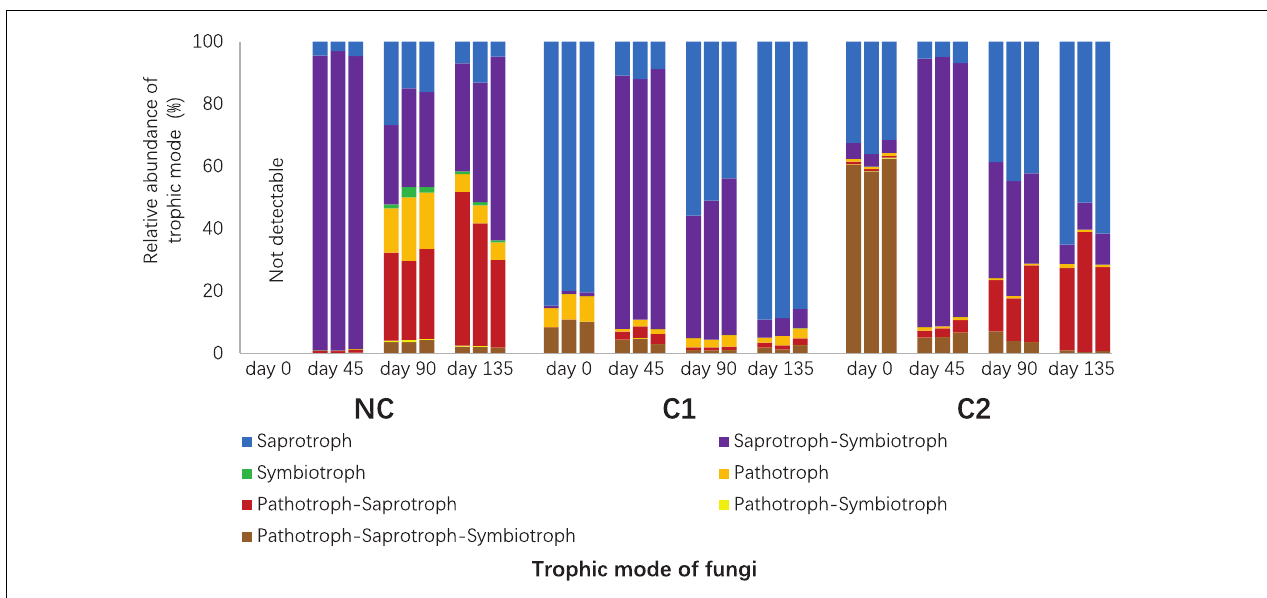
FIGURE 4 | Relative abundances of trophic modes in the fungal communities predicted with FUNGuild. The unassigned portion was